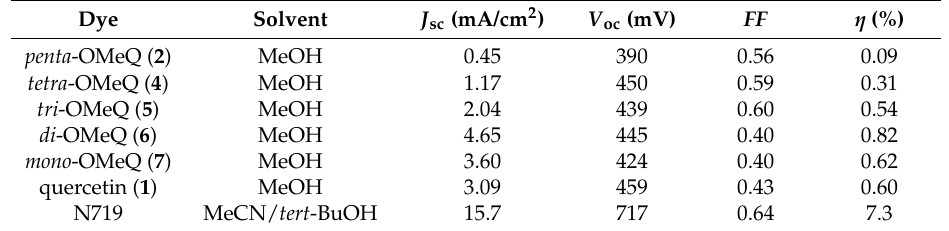
Table 4. Photovoltaic properties of the dye-sensitized solar cells (DSSCs) sensitized with O -methyl quercetins ( 1 , 2 , 4 – 7 ) a,b . Dye